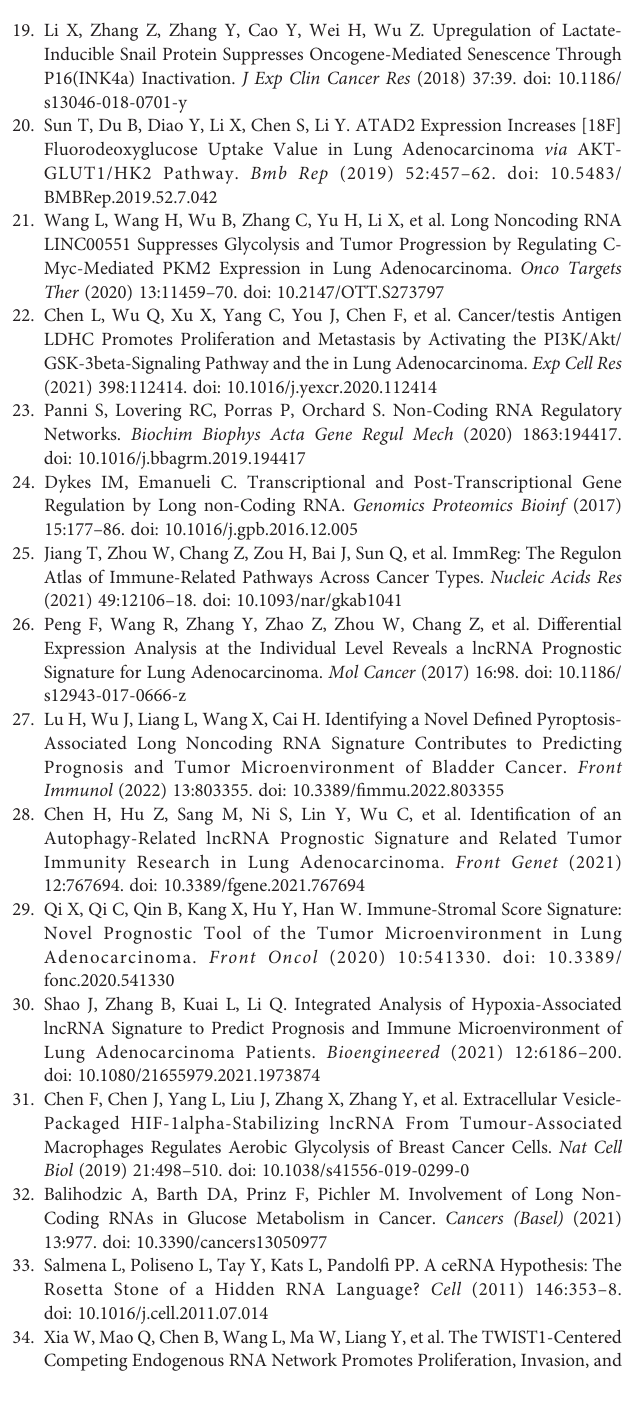
subtype of LUAD versus low-risk subtype of LUAD. (B) T cell exclusion score analysis. (C) T-cell dysfunction score analysis. (D) The correlation between anti- CTLA-4 treatment and riskscore. Supplementary Figure 3 | Relationship between The LMR-lncRNA Signature and Chemotherapeutics. (A – F) The half-maximal inhibitory concentration (IC50) of six common targeted therapeutics and